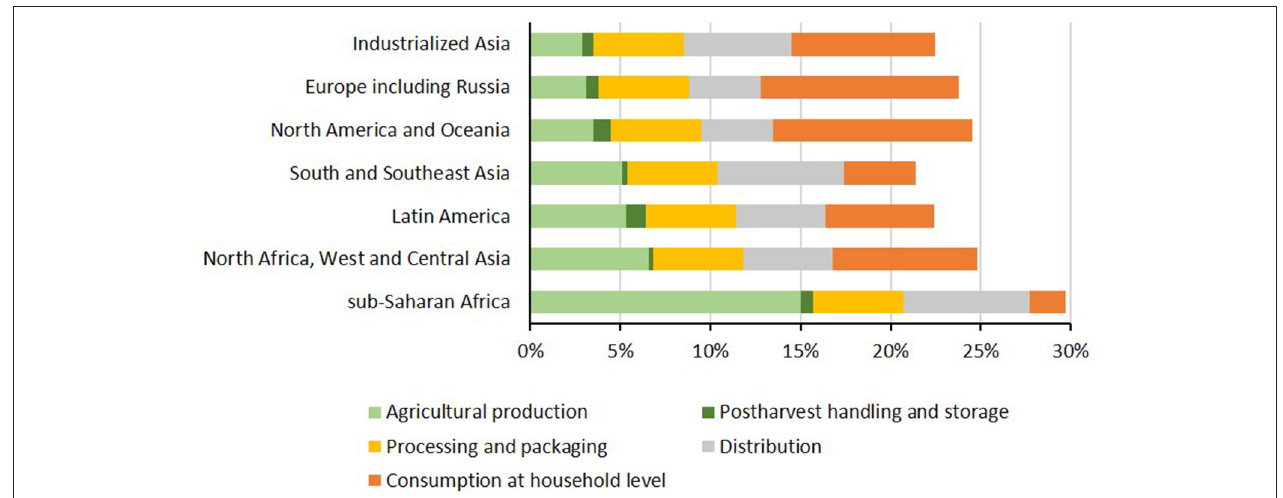
FIGURE 2 | Percentage of meat lost and wasted from various stages of the food supply chain for different regions